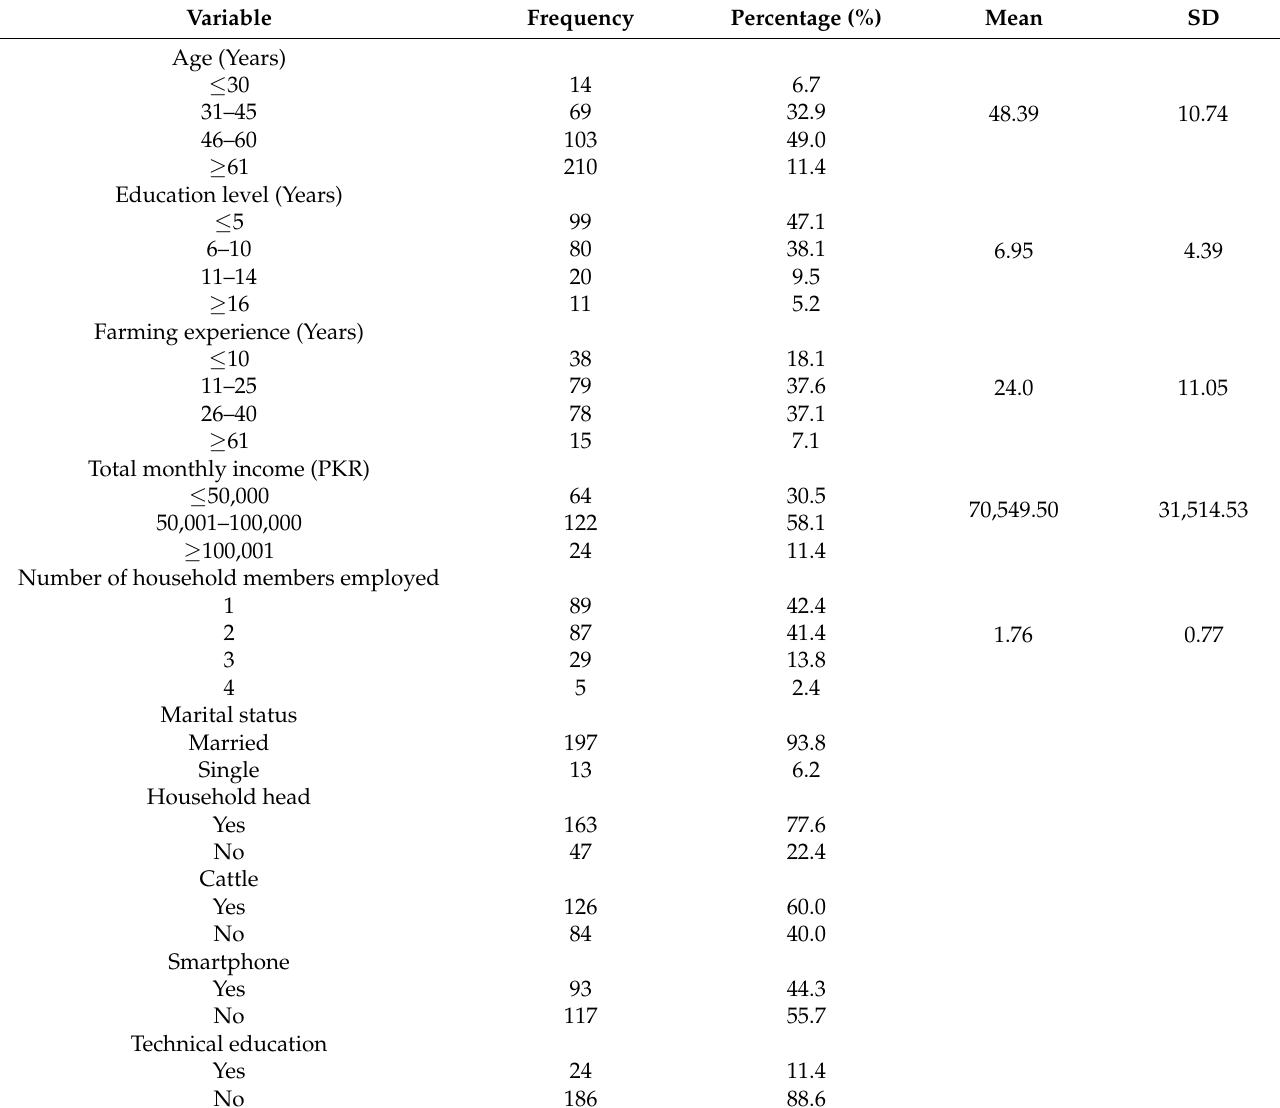
Table 1. Demographic characteristics of